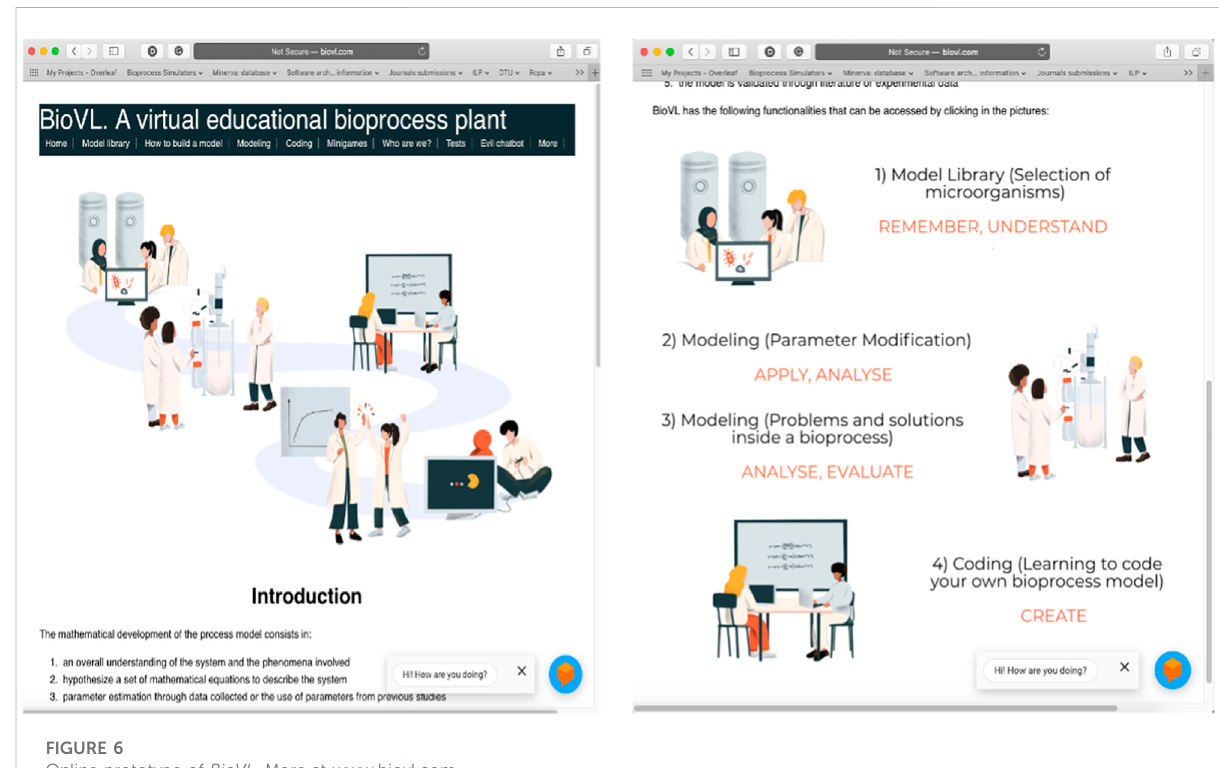
FIGURE 6 Online prototype of BioVL . More at